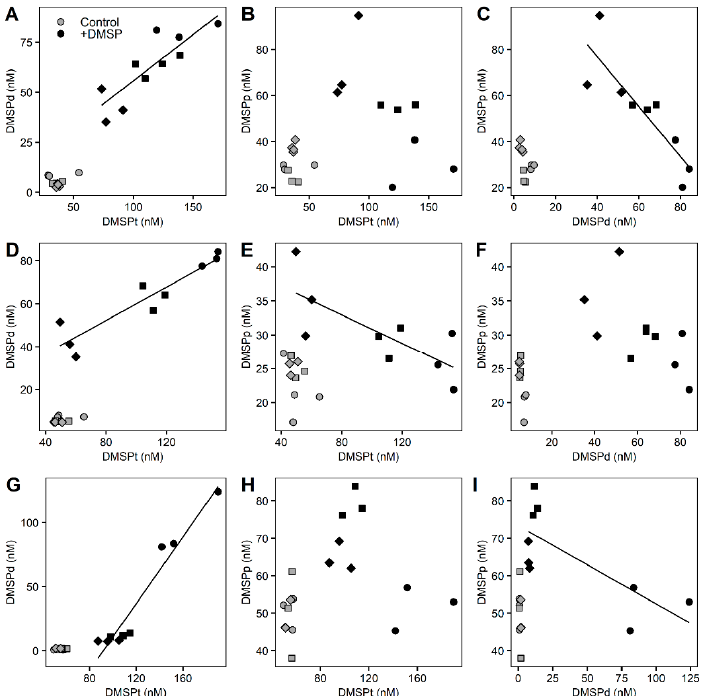
Figure 6. Correlations between the different DMSP concentrations for the fractionated marine microbial community . Control samples (light grey) and enriched DMSP samples (black) for time 0 h (circles), 3 h (squares), and 6 h (diamonds) are represented. Top row: > 8 µm fraction ( A – C ), middle row: 3–8 µm fraction ( D – F ), bottom row: 0.22–3 µm fraction ( G – I ). Significant correlations: ( A ) r 2 = 0.722, p = 0.0019; ( C ) r 2 = 0.746, p = 0.0027; ( D ) r 2 = 0.861, p = 0.0003; ( E ) r 2 = 0.565, p = 0.0195; ( G ) r 2 = 0.942, p = 0.01; ( I ) r 2 = 0.551, p = 0.02.